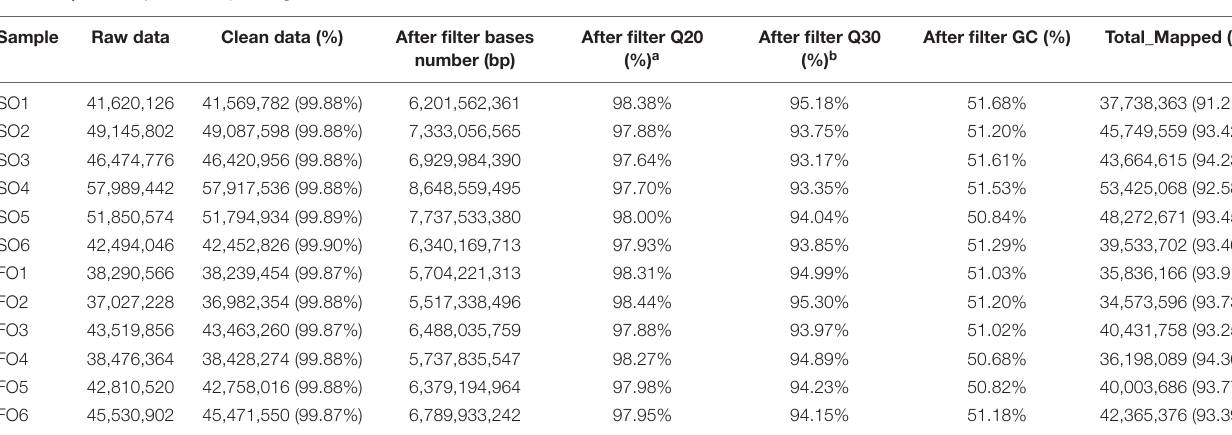
TABLE 5 | Summary of the sequencing